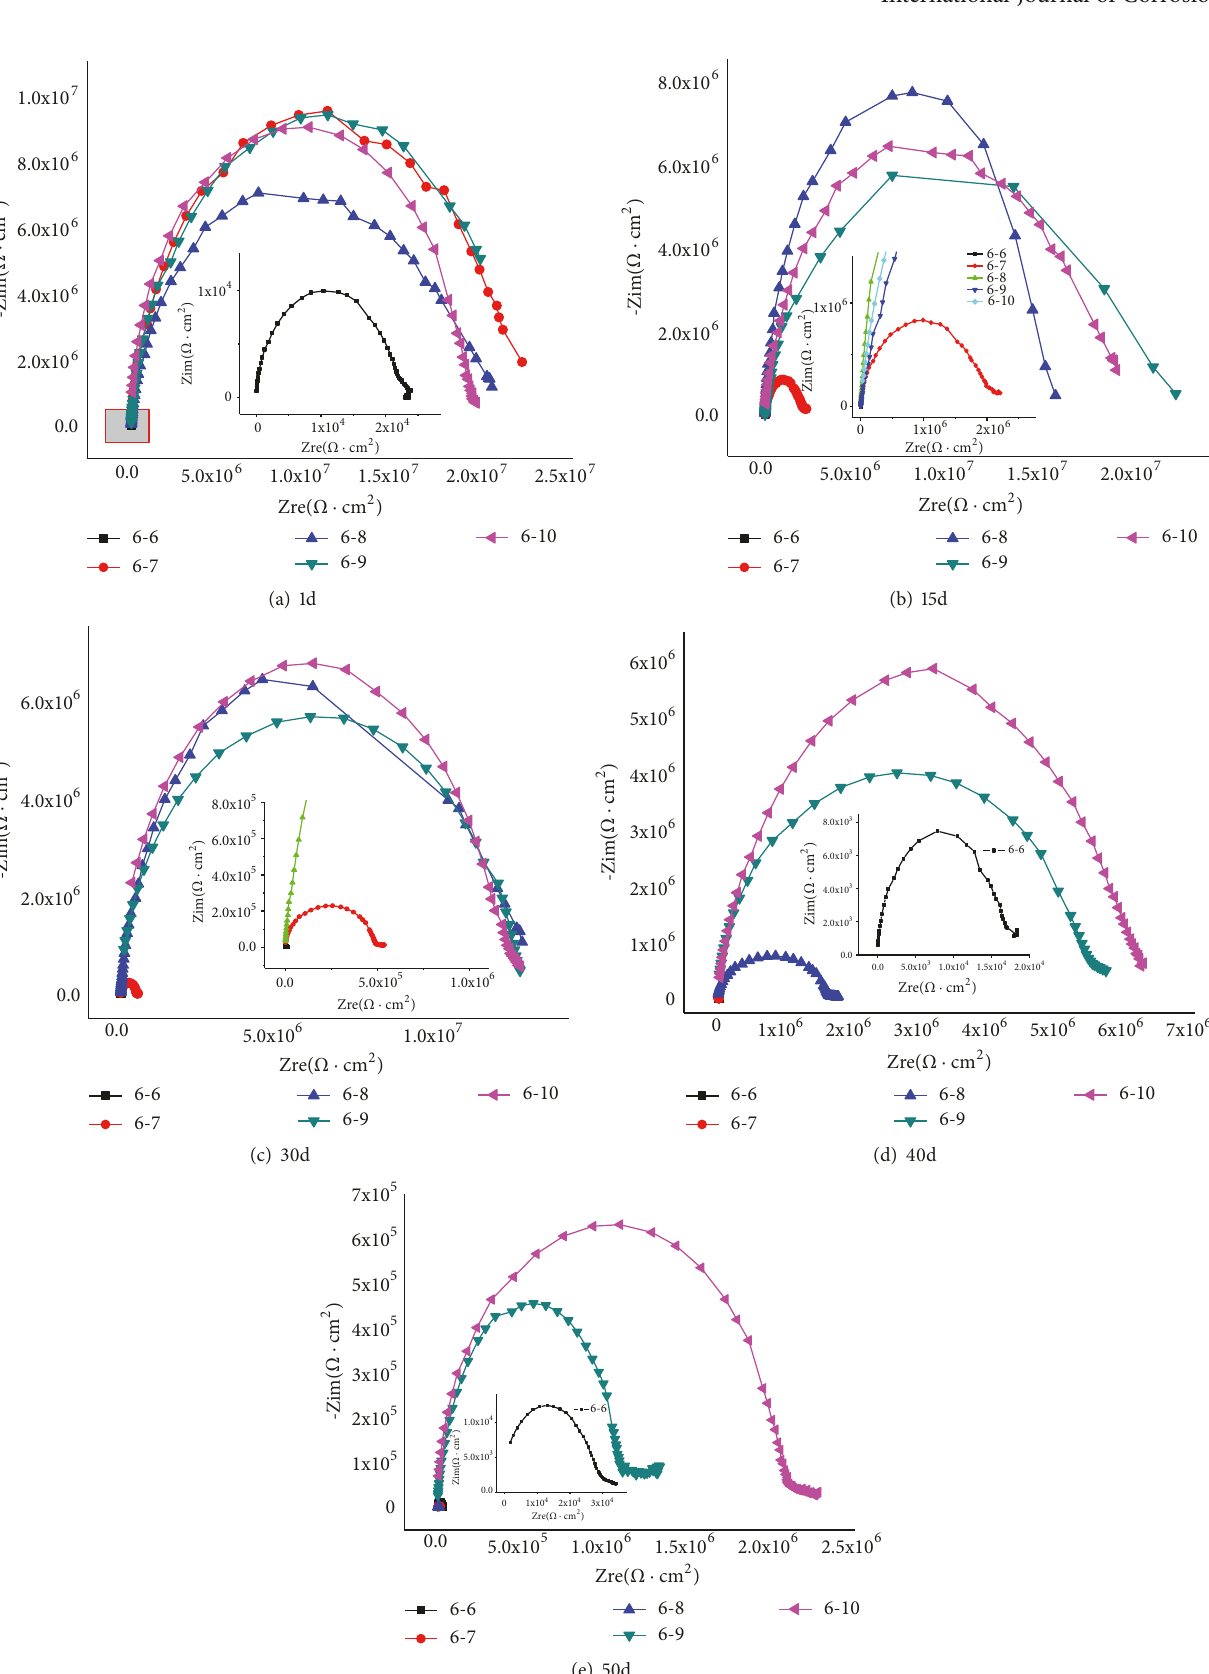
Figure 7: Nyquist diagrams of part of the point soaking for 1d, 15d, 30d, 40d, and